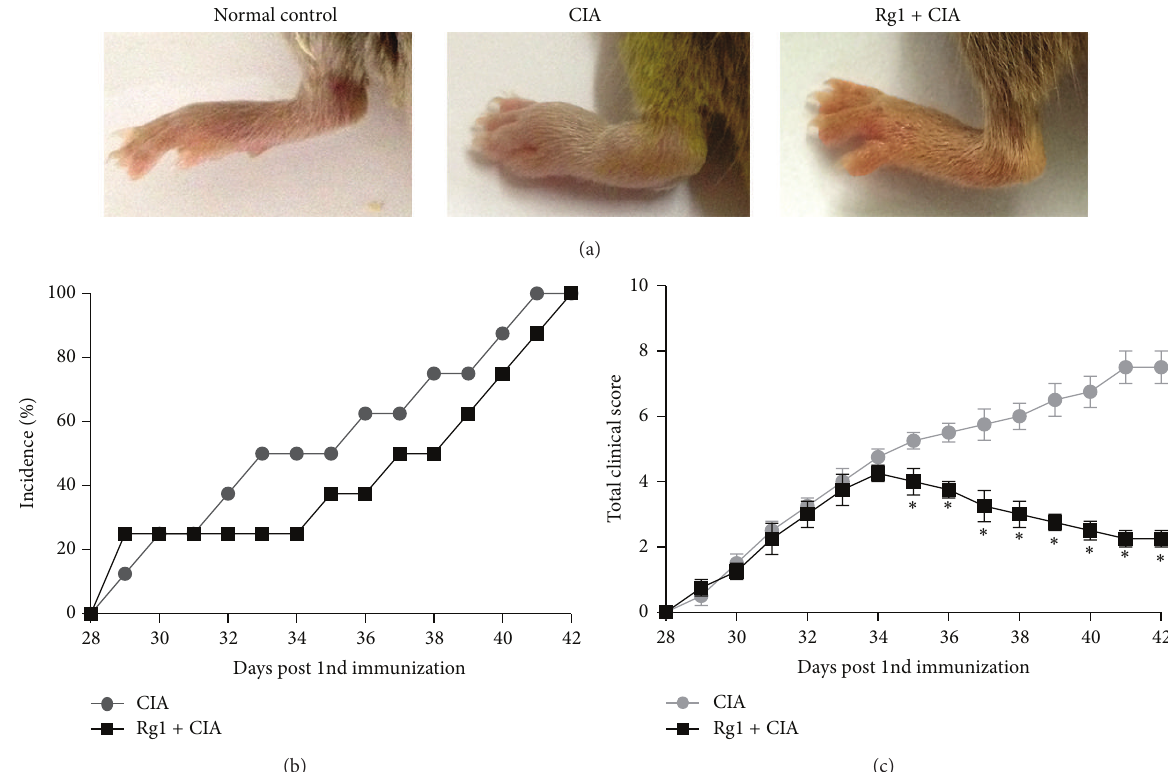
Figure 6: Effects of Rg1 on incidence, arthritis scores, and paw swelling with prolonged time in CIA mice. Mice were intraperitoneally injected with placebo and Rg1 for 14 days after 28 days since the first immunization. Paw thickness (a), incidence (b), and arthritis scores (c) were measured at 1-day intervals. Rg1 markedly reduced the mean arthritis scores and paw swelling. Data are the mean ± SD of eight mice. ∗ 𝑃 < 0.05 , compared with relevant